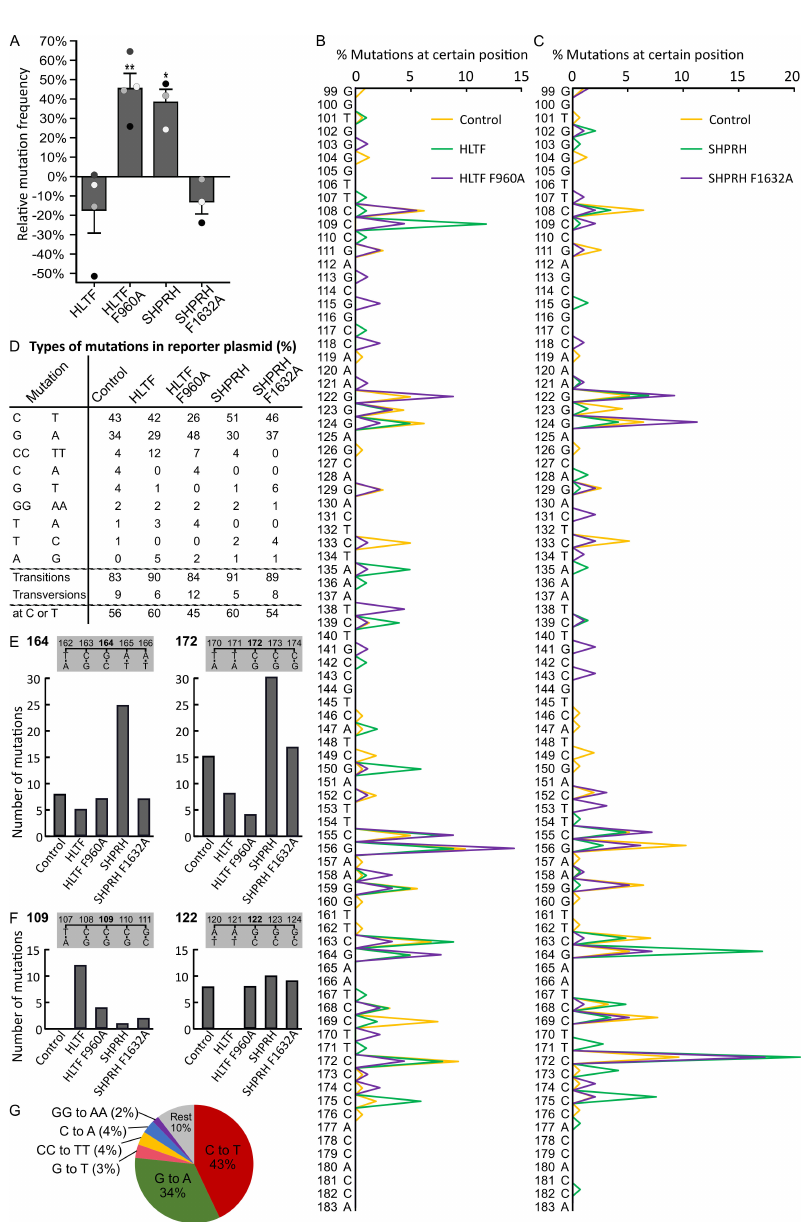
Figure 3. Mutation of APIM in HLTF and SHPRH results in differences in mutation frequencies and mutation spectra. ( A ) Mutation frequencies after overexpression of HLTF, HLTF F960A, SHPRH, or SHPRH F1632A, together with SupF reporter plasmid pSP189, relative to control (reporter plasmid only) in HEK293 cells from three or four biological replica (depicted as white, grey, and black dots). DNA from each biological replica was transformed until obtaining 1000–4000 colonies per replica. The total number of colonies counted are: HLTF ( n = 14700), HLTF F960A ( n = 13321), SHPRH ( n = 11183), SHPRH F1632A ( n = 14709), and control ( n = 17560). Two-sided Student’s t -test relative to control, * p < 0.05, ** p < 0.01. ( B , C ) Mutation spectra received from sequencing mutant colonies from (A). HLTF ( n = 102), HLTF F960A ( n = 91), SHPRH ( n = 152), SHPRH F1632A ( n = 102), and control ( n = 163). ( D ) Quantification of different mutations using sequencing results from (B,C). Mutations with prevalence ≥ 2% are shown. Mutations at T or C bases (putative coding strand mutations) in supF ( E ) Mutations at position 164 and 172 in supF isolated from cells overexpressing HLTF, HLTF F960A, SHPRH, or SHPRH F1632A compared to control. ( F ) Mutations at position 109 and 122 in supF isolated from cells overexpressing HLTF, HLTF F960A, SHPRH, or SHPRH F1632A compared to control. ( G ) Distribution of mutations using sequencing results from (B,C) received from reporter plasmids isolated from control